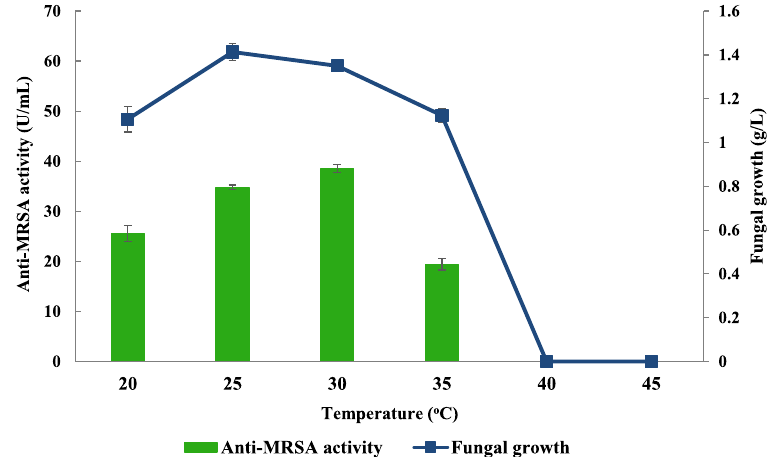
Fig. 5. Effects of temperature on the production of anti-MRSA activity and fungal growth by L. pseudotheobromae IBRL OS-64. Different letters indicate significant differences between means (Duncan, p<0.05). Standard deviation values of triplicate analyses are shown by error